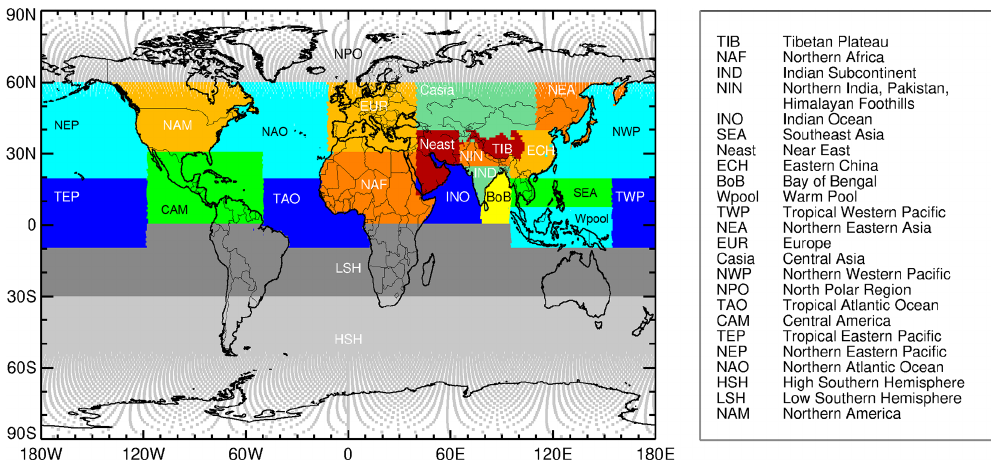
Figure 9. CLaMS artificial surface emission tracers by region based on previous simulations described in Vogel et al. (2015, 2019), with higher resolution regions at coastal boundaries mainly in southeastern Asia (INO, IND, NIN, BoB, Neast, and ECH), as well as in other regions (TIB, NEA, NAF, TAO, NAM, NEP, and NAO). Adapted from Wetzel et al. (2021), where these defined regions were also used for the analysis during the WISE